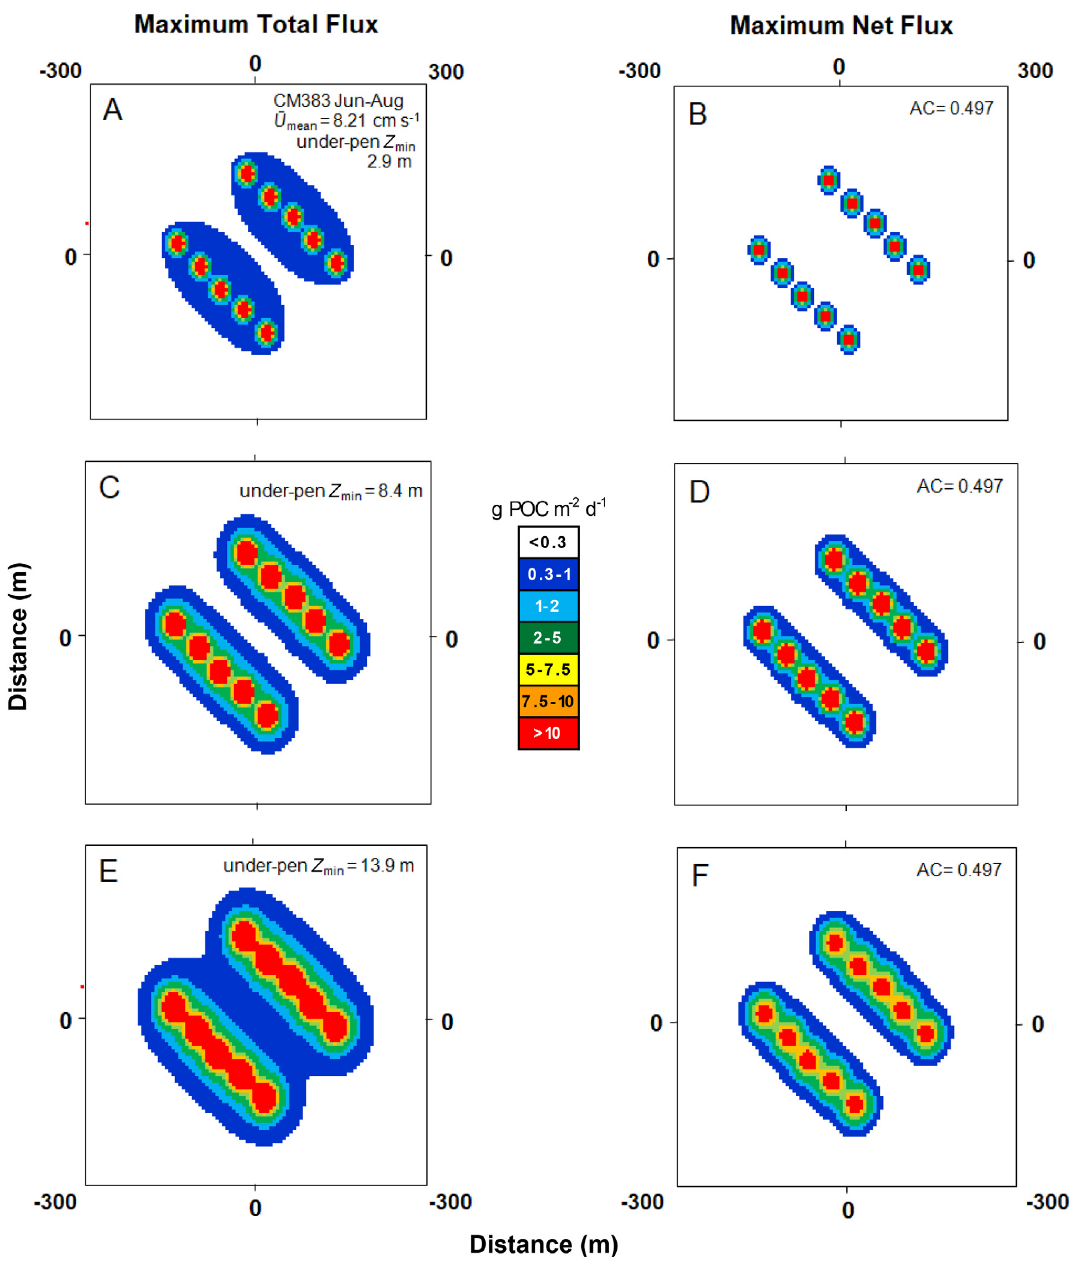
Fig. 7. Model output for 2 enrichment contour intervals and maximum total and net POC flux under net-pens as in Fig. 6 for 3 fecal size classes but with current statistics from CM383 modified for net-pen side-wall drag effects (Table 2) and 3 under-pen depths. Z min is Z m corrected for NP z (Table 1). Addition of NP z (10 m) represents minimum, mean and maximum under-cage depths for a normal tide in Bliss Harbour (Chang et al.